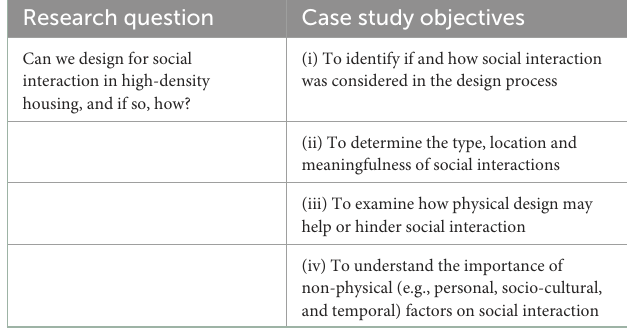
TABLE 1 Research question and case study objectives.